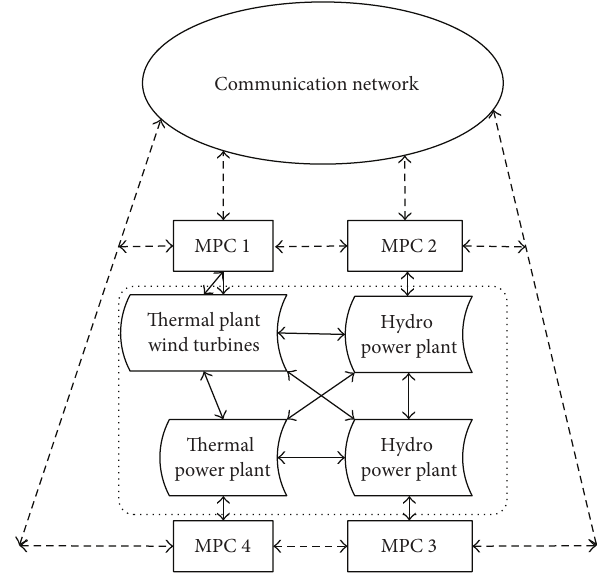
Figure 7: Block diagram of DMPC for power system with wind